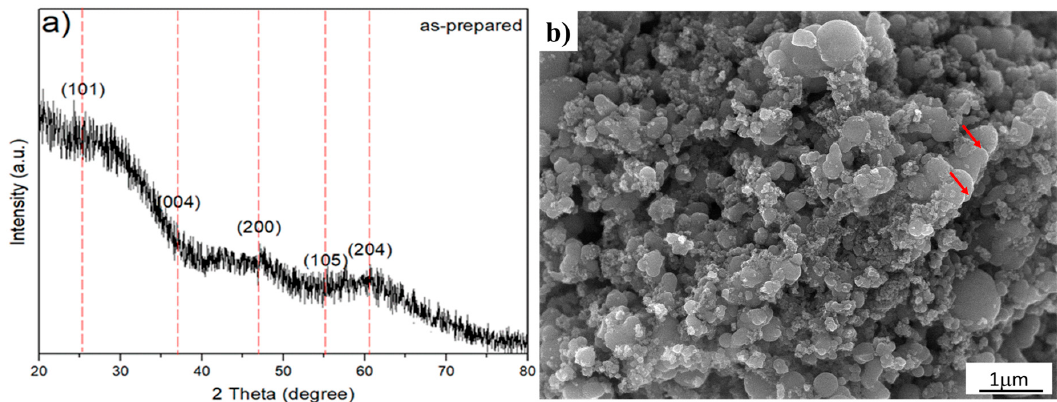
Figure 2. As-prepared sample. ( a ) Nanocrystalline TiO 2 XRD pattern of the sample synthesized by ultrasonic radiation for 50 min, whereby the dashed lines correspond strong diffraction peaks according to JCPDS card No. 21-1272 (anatase TiO 2 ); ( b ) Typical FESEM image depicting the cavitation effect by sonochemical means.